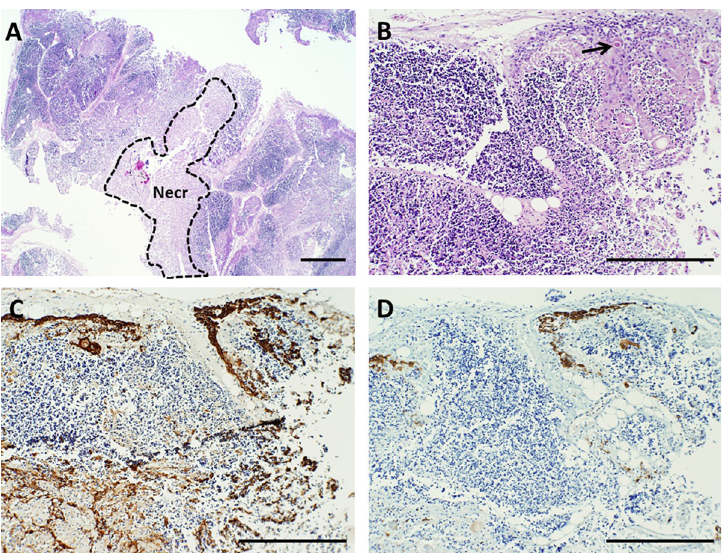
Fig 4. Architecture of cultured thymus, day 9. A, B. Hematoxylin and eosin (H&E) stain. Few if any live T cells or thymic epithelial cells are present in the pale-staining area in A that is enclosed by the dotted line, which is almost completely necrotic (Necr). Most nuclei formerly present in this region have been degraded, a process called karyolysis. Other areas where the nuclei from residual thymocytes have not been completely degraded continue to stain dark blue with hematoxylin. Arrow in B points to a Hassall body. C. Pan-cytokeratin (AE1/AE3) immunoreactivity. D. Cytokeratin 14 (CK14) immunoreactivity. Brown color indicates a positive reaction with antibody. Bar represents 1 mm in A and 500 μ m in